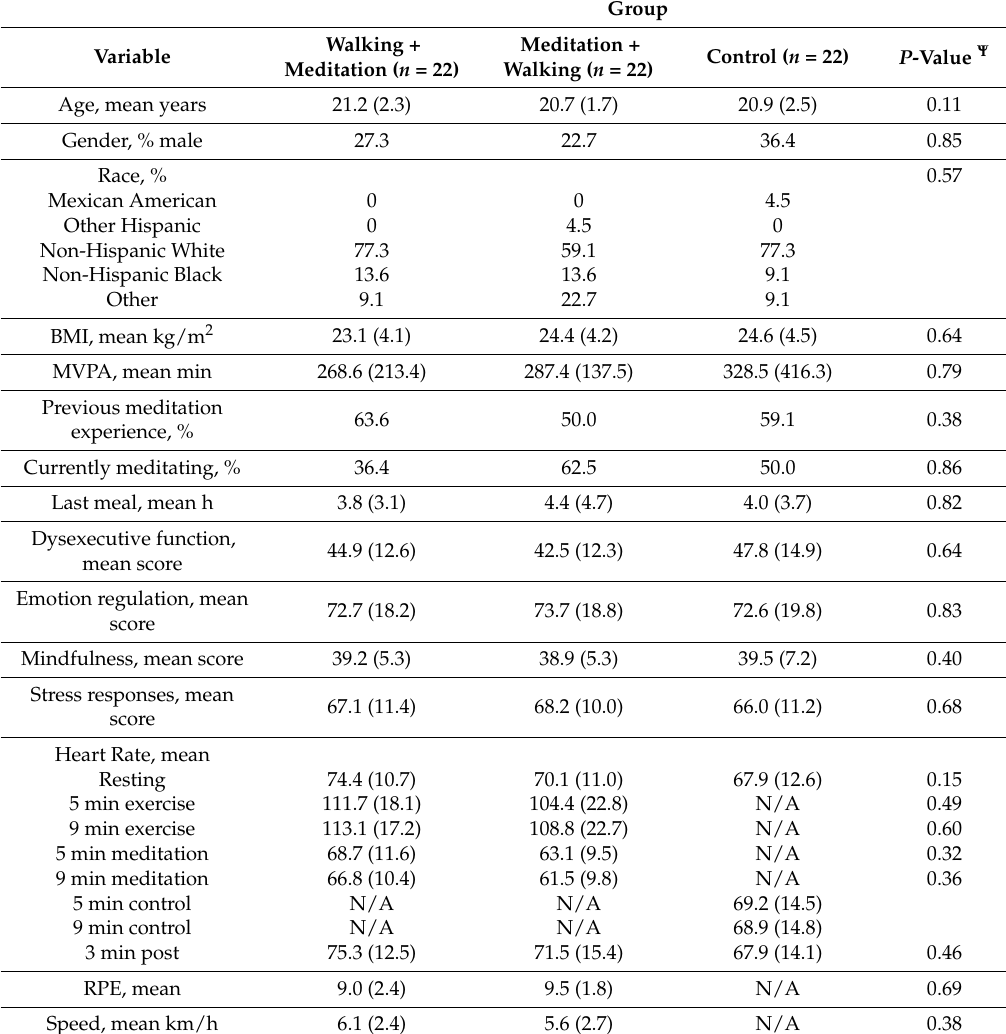
Table 1. Demographic characteristics of the analyzed sample ( n =